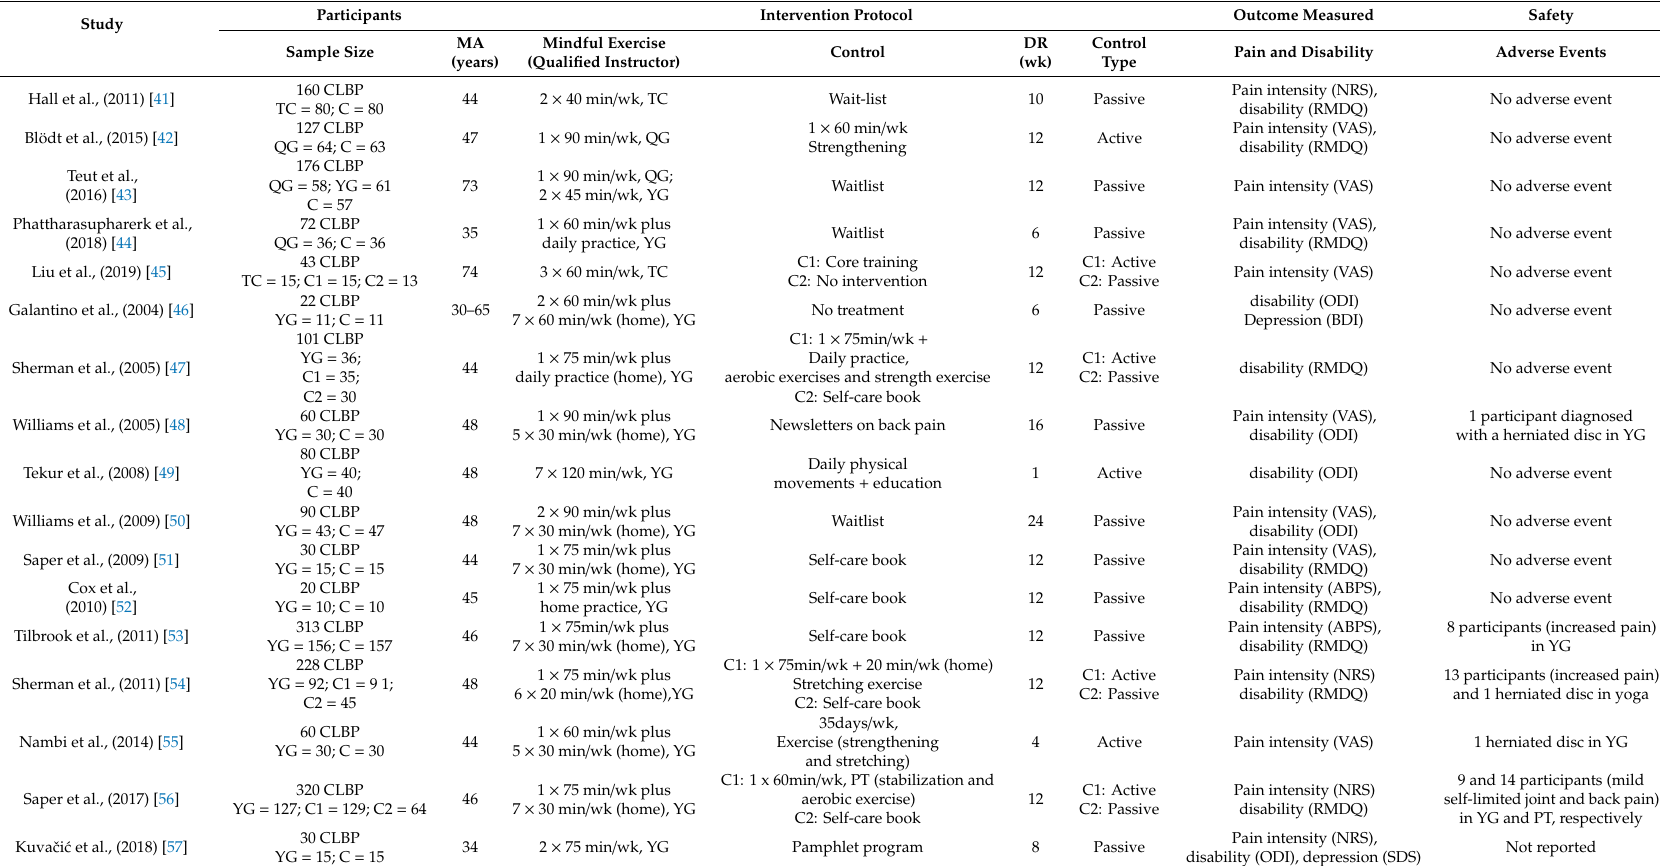
Table 1. Characteristics of randomized controlled trials in the